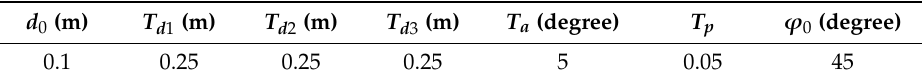
Table 1. Values of parameters used in the test.